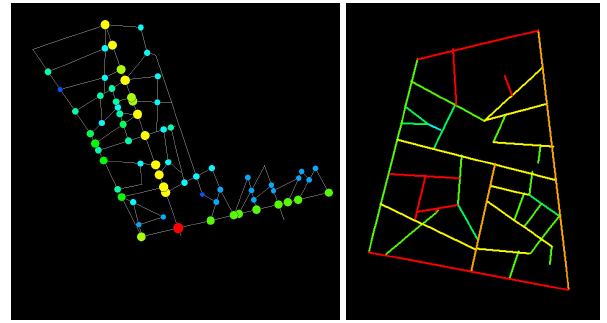
Figure 8. Space Syntax analysis of the street network in an organic (historic centre) and a pre-planned (Magheru Boulevard) area, fol- lowing two modes of